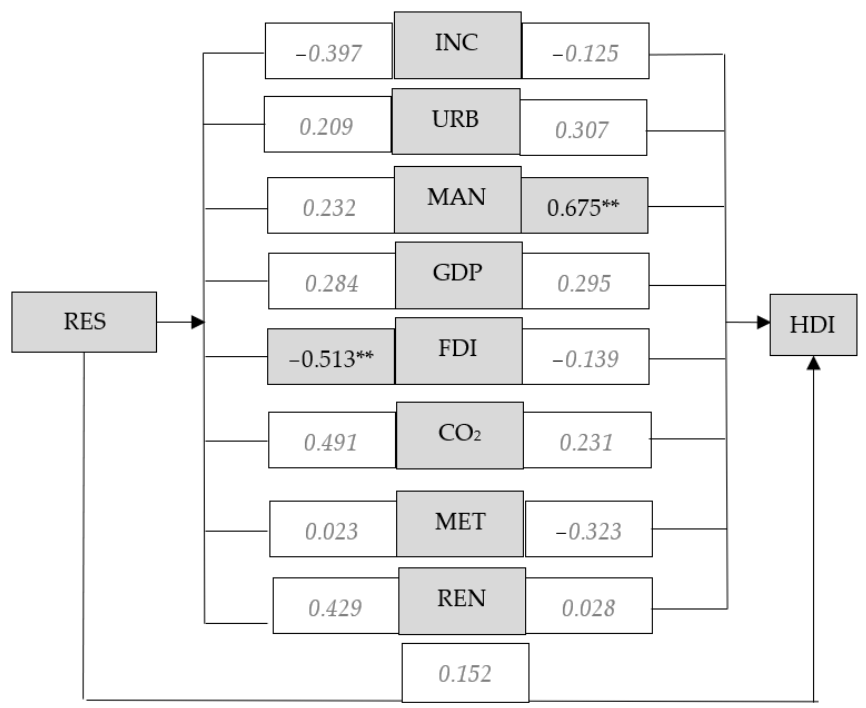
Figure A6. Role of the residential energy use per capita in explaining HDI of OMS, 2018. Note: the insignificant values are marked with italics and grey. ** 5% significance level.